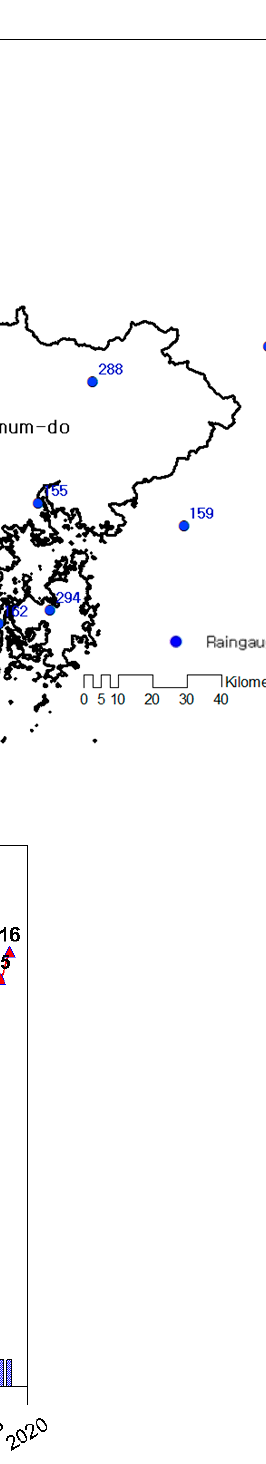
Figure 4. Status of drought damage in Gyeongsangnamdo by year.